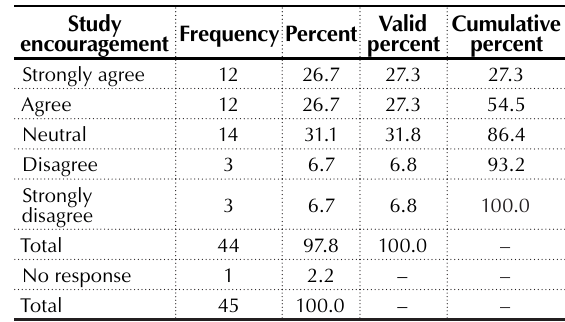
Table 4. Responses on study encouragement